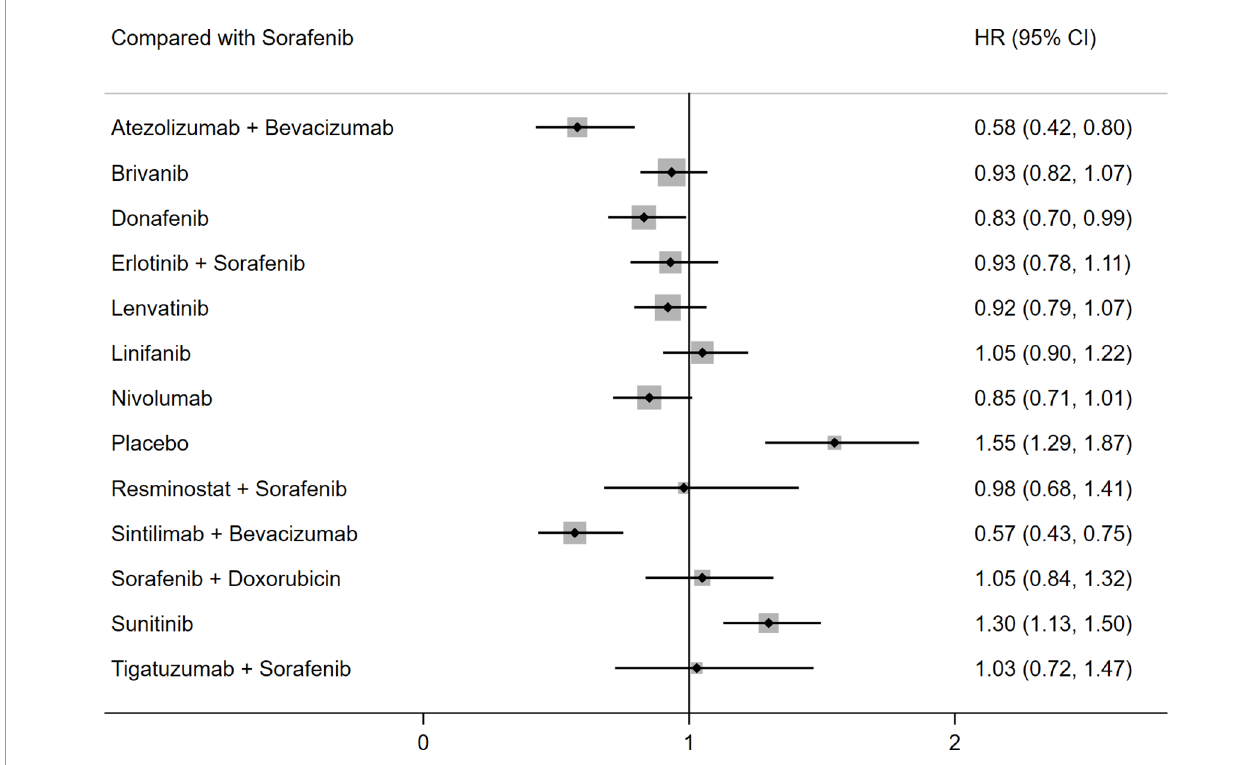
FIGURE 2 | Forest plot for HR of signi fi cant difference between the ef fi cacy of the remaining treatment strategies and sorafenib ( Table 2 and Figure 2 ). P score for the outcome of OS were shown in Supplementary Figure 3A .